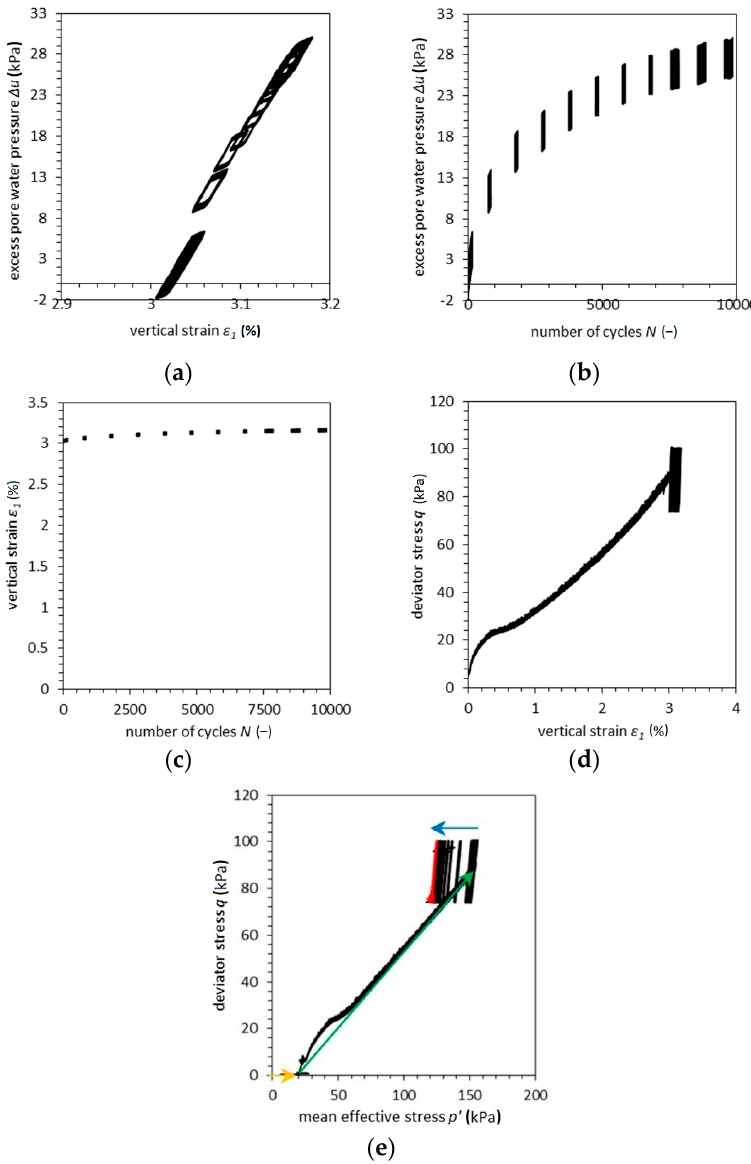
Figure 6. Results of the cyclic triaxial test for sandy silty clay under a confining pressure of 125 kPa and under the K 0 consolidation, initial void ratio e 0 = 0.399, K 0 = 0.71—sample 2.2: ( a ) Excess pore water pressure versus vertical strain characteristic, ( b ) excess pore water pressure characteristic versus number of cycles, ( c ) vertical strain characteristic versus number of cycles, ( d ) deviator stress–vertical strain relationship, and ( e ) the deviator stress–mean effective stress relationship (red color—last 10 cycles; arrow color—violet: Saturation phase, green: Consolidation phase, blue: Cyclic loading program).